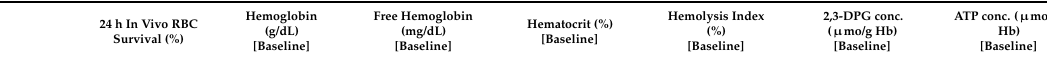
Table 4. Preparation of porcine erythrocytes and storage lesion, sorted by year of